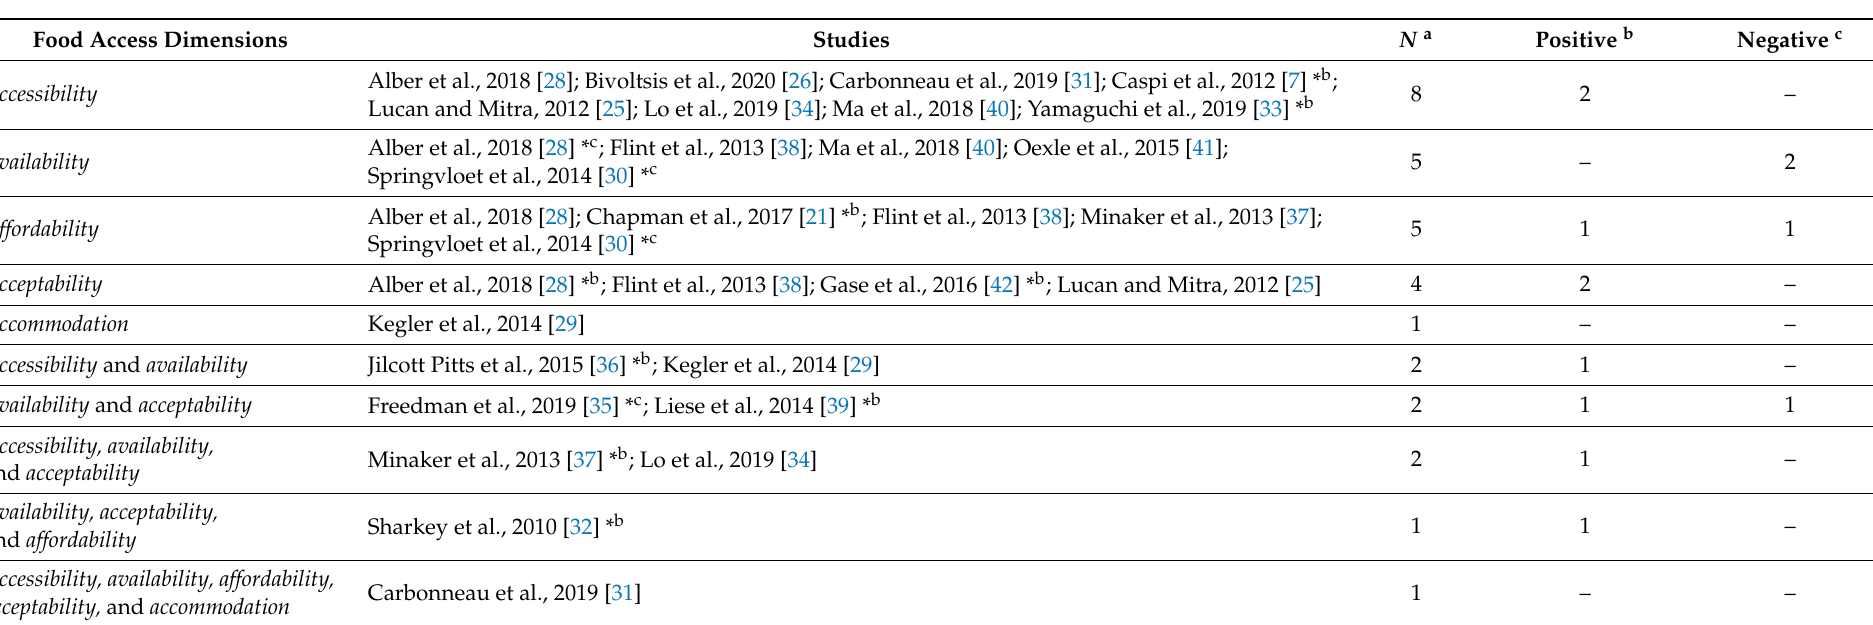
Table 5. The frequencies at which the 19 studies extracted food access dimensions in their analyses and significant association between dimensions and healthy food or